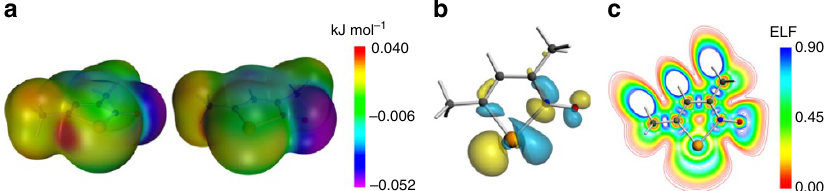
Figure 5 | The aggregation of 1 originates in its electronic properties. ( a ) Two views of the map of electrostatic potential for a molecule of 1c ; ( b ) LUMO of 1c ; ( c ) contour plot of the electron localization function in the iso-tellurazole plane.